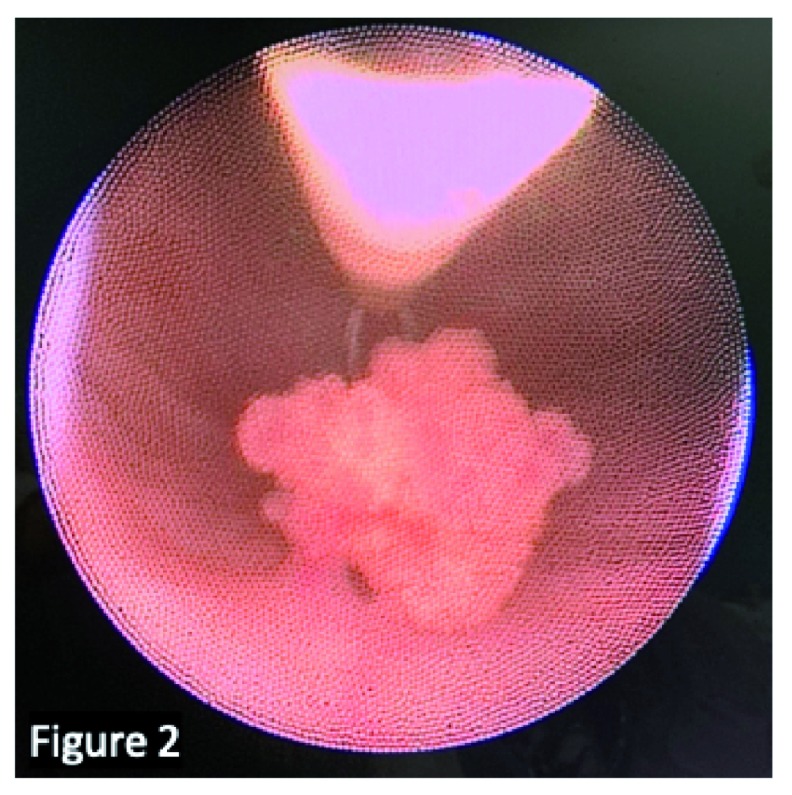
Transurethral resection of a solitary, non–muscle invasive, and low-grade papillary urothelial neoplasms of low malignant potential.We confirm that the patient gave us permission to use this image.